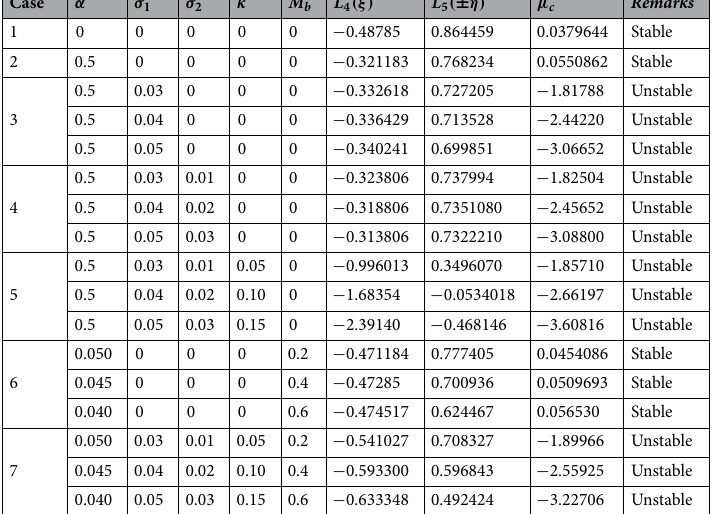
0.0549, γ 0.0004527, T 0.01 ) . = = − =